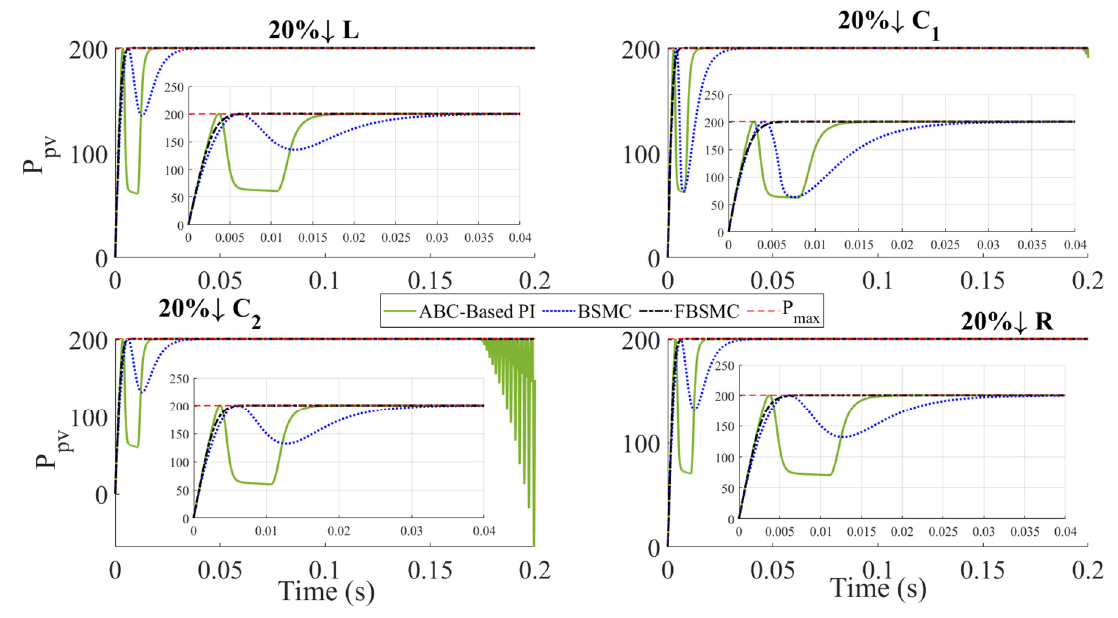
Figure 11. Extracted PV power for a 20% decrease in the system parameters. Table 6. Dynamic efficiency for a 20% increase in the system parameters.